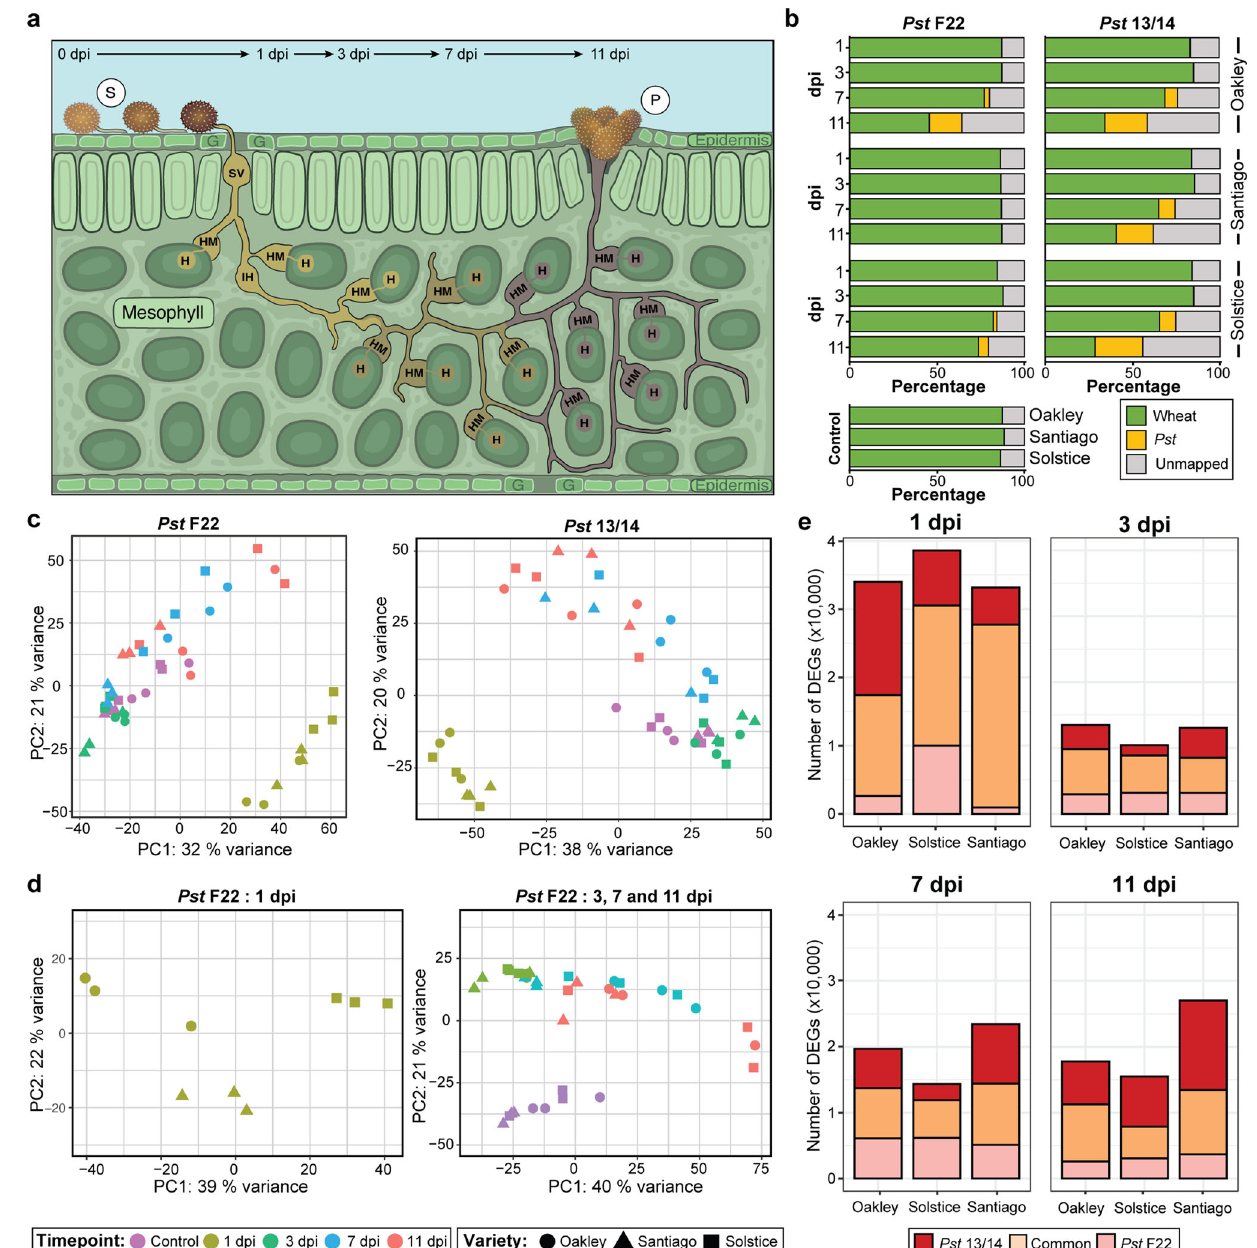
Fig. 1 Early stages of Pst infection induce massive transcriptional reprogramming of the wheat host, irrespective of its susceptibility level. a Diagram of the stages of Pst development during plant infection. The time points selected for RNA-seq analyses (1, 3, 7 and 11 days post-inoculation [dpi]) are highlighted. S uredinospore, SV substomatal vesicle, IH invasive hyphae, HM haustorial mother cell, H haustorium, P pustule, G guard cell. Inspired by a schematic illustration from 61 . b Percentage of reads mapping to the wheat or Pst reference genomes across wheat varieties and pathogen isolates. Following quality fi ltering, RNA-seq reads were mapped to the Pst reference genome (isolate Pst -104E 18 ) and wheat reference genome Refseq v1.1 17 . Values represent an average of three independent biological replicates (independent infected plants) for each Pst – variety pair. c Principal component analysis (PCA) of wheat gene expression pro fi les shows that samples from all Pst – variety pairs cluster into two well-de fi ned groups: 1) 1 dpi; and 2) all remaining time points. d Independent PCA on 1 dpi samples only (left) or remaining time points (right) illustrating the clustering of 1 dpi samples by host variety, for infection by Pst isolate F22. e Differentially expressed genes (DEGs) are more numerous at 1 dpi, with samples infected with Pst isolate 13/14 showing more isolate-speci fi c DEGs than those infected with Pst isolate F22. The number of DEGs was de fi ned at each time point by comparing normalised transcript abundance for each Pst -wheat interaction against the corresponding mock-inoculated control using a negative binomial regression (Wald test) in DESeq2. Genes were considered differentially expressed when q -value < Wheat gene expression pro fi les are most notably altered early Pst – variety interaction. We normalised our data to account for in the Pst infection process . To assess the host response to Pst library size and samples with low read counts before conducting a infection under different levels of susceptibility, we determined principal component analysis (PCA). We generated scatterplots wheat transcript abundances at each time point for each of the fi rst two principal components for each Pst isolate, which